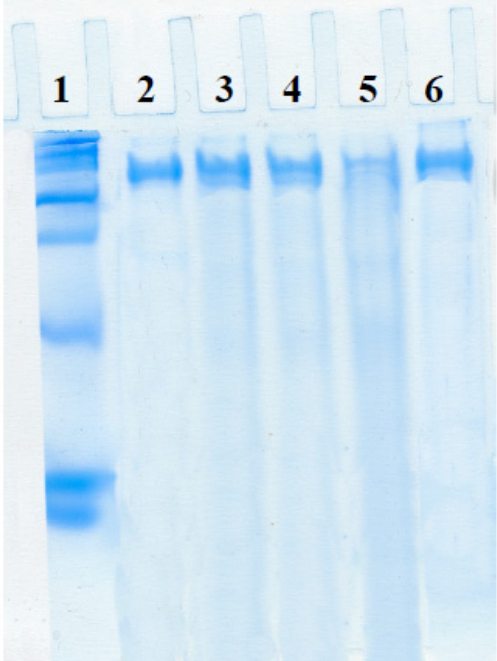
Figure 9. Electrophoresis in standard conditions. 1 : Protein standard (high range SDS-Page standard stained with coomassie G-250 stain; 2 : Soluble laccase; 3 : SBA-15-L; 4 : SBA-15-S; 5 : MS-3030; 6 :